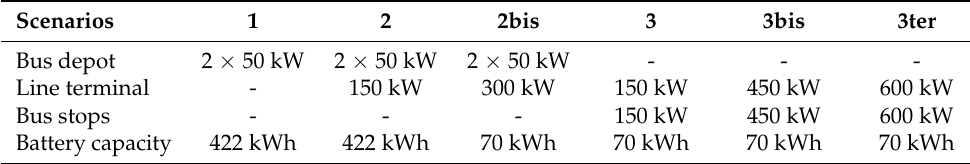
Table 4. Location and power of charging stations in the different